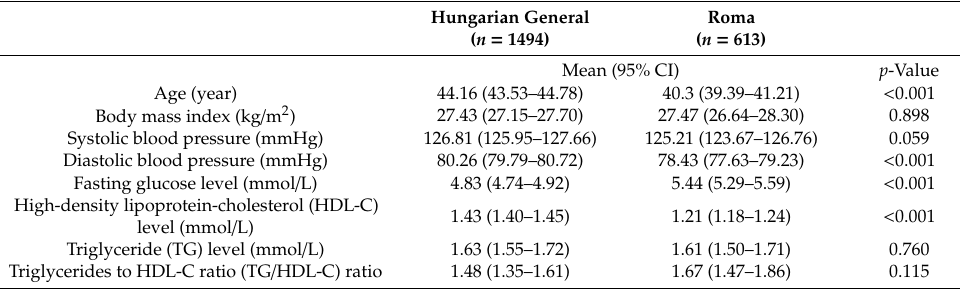
Table 1. Demographic characteristics of the study